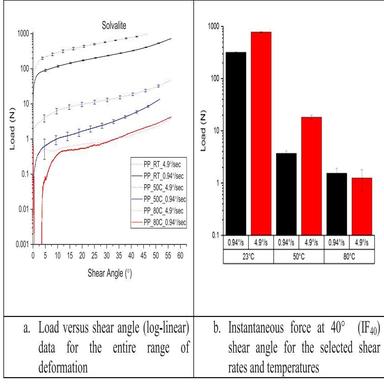
PF test results (log-linear) of CEP-TW1 at different temperatures and shear rates.